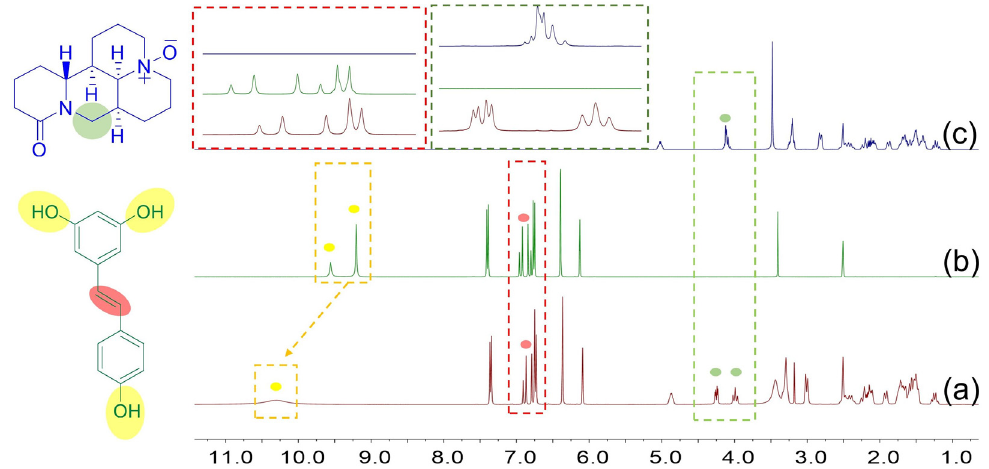
Figure 4. One-dimensional 1 H NMR spectra of co-amorphous forms of OMAR-RES ( a ), resveratrol d 6 ( b ), and oxymatrine ( c ) dissolved in DMSO- d 6 . (b), and oxymatrine (c) dissolved in DMSO-